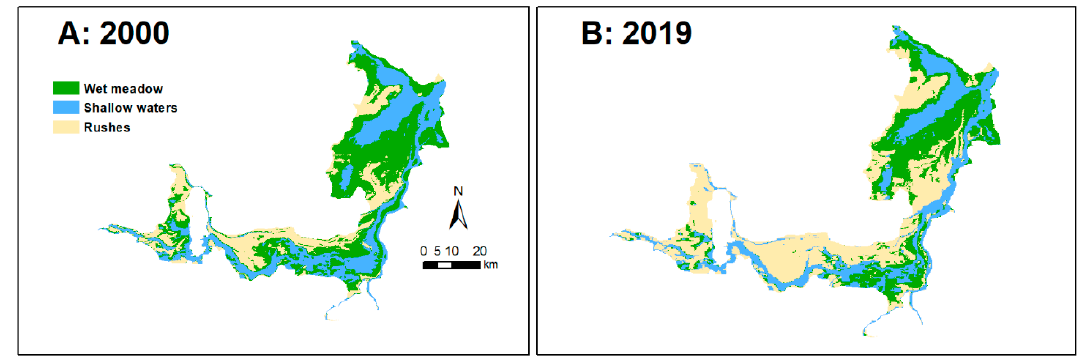
Figure 6. Comparison of wetland distribution in ( A ) 2000 and ( B ) 2019. Wetland maps for other years are in the supplementary material.